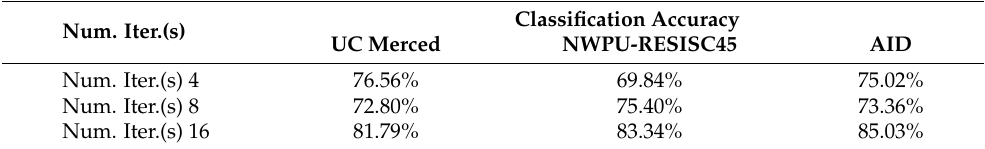
Table 8. Influences of the number of iterations of the GRU-CML module on performance. Num.